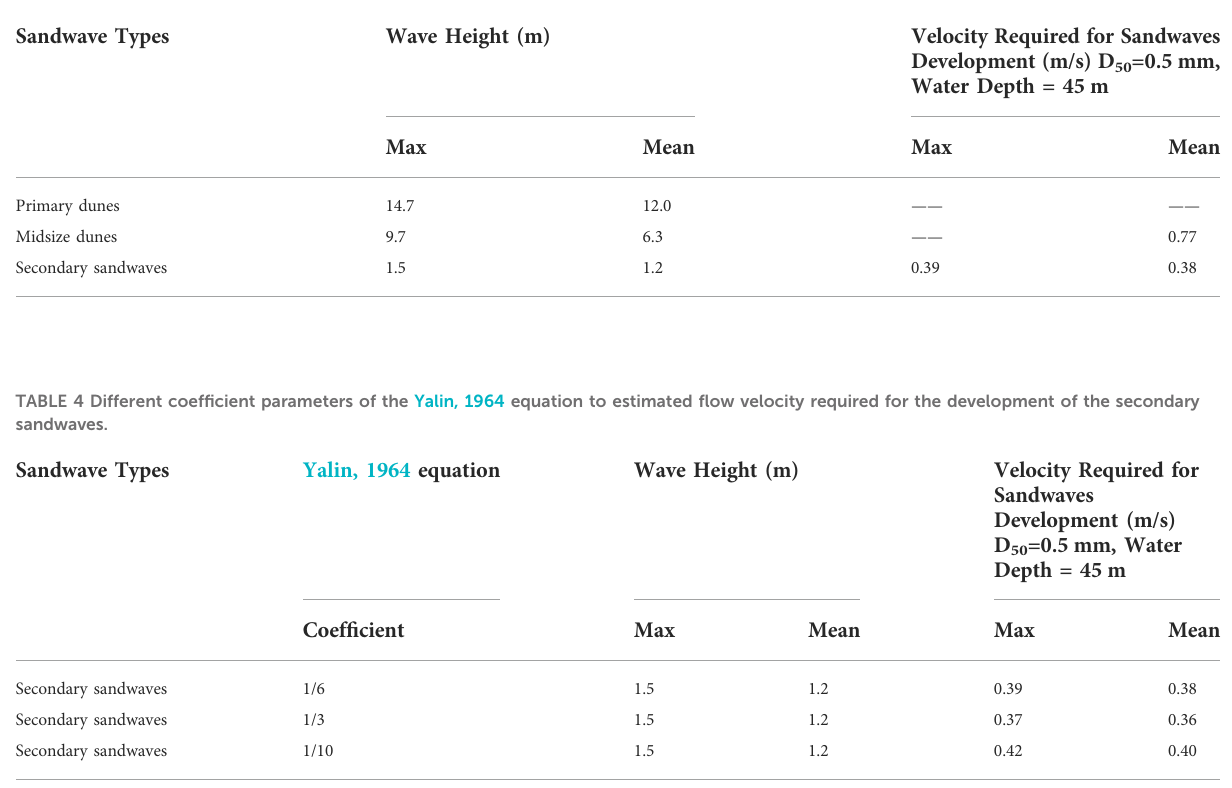
TABLE 3 Estimated fl ow velocity required for the development of the three sizes of sandwave observed in this study.